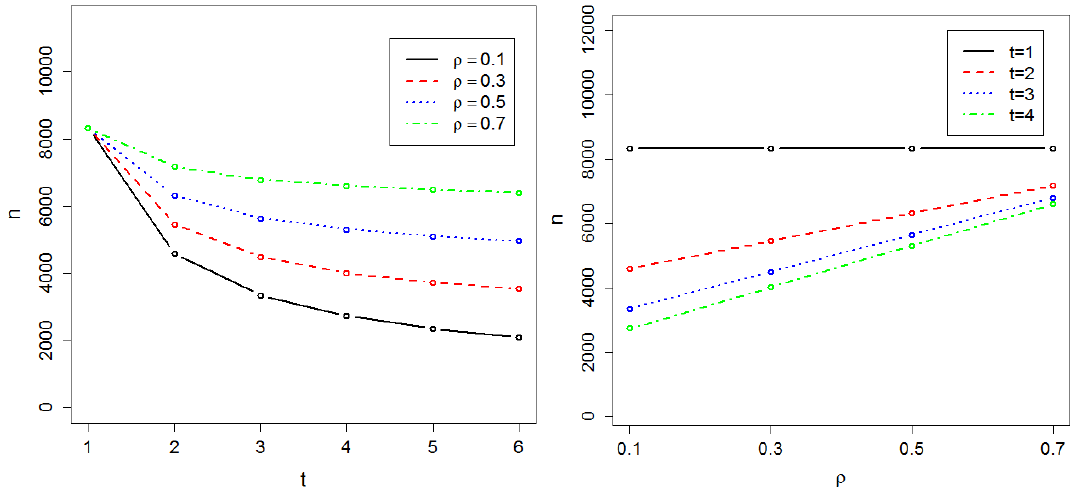
Figure 2. Required sample size in the presence of population substructure. The sample size is indicated by n. The required sample size to achieve 0.8 power at the significance level α = 10 − 8 has been calculated as a function of t, the number of time points, and ρ, the correlation between measurements at two different time-points.